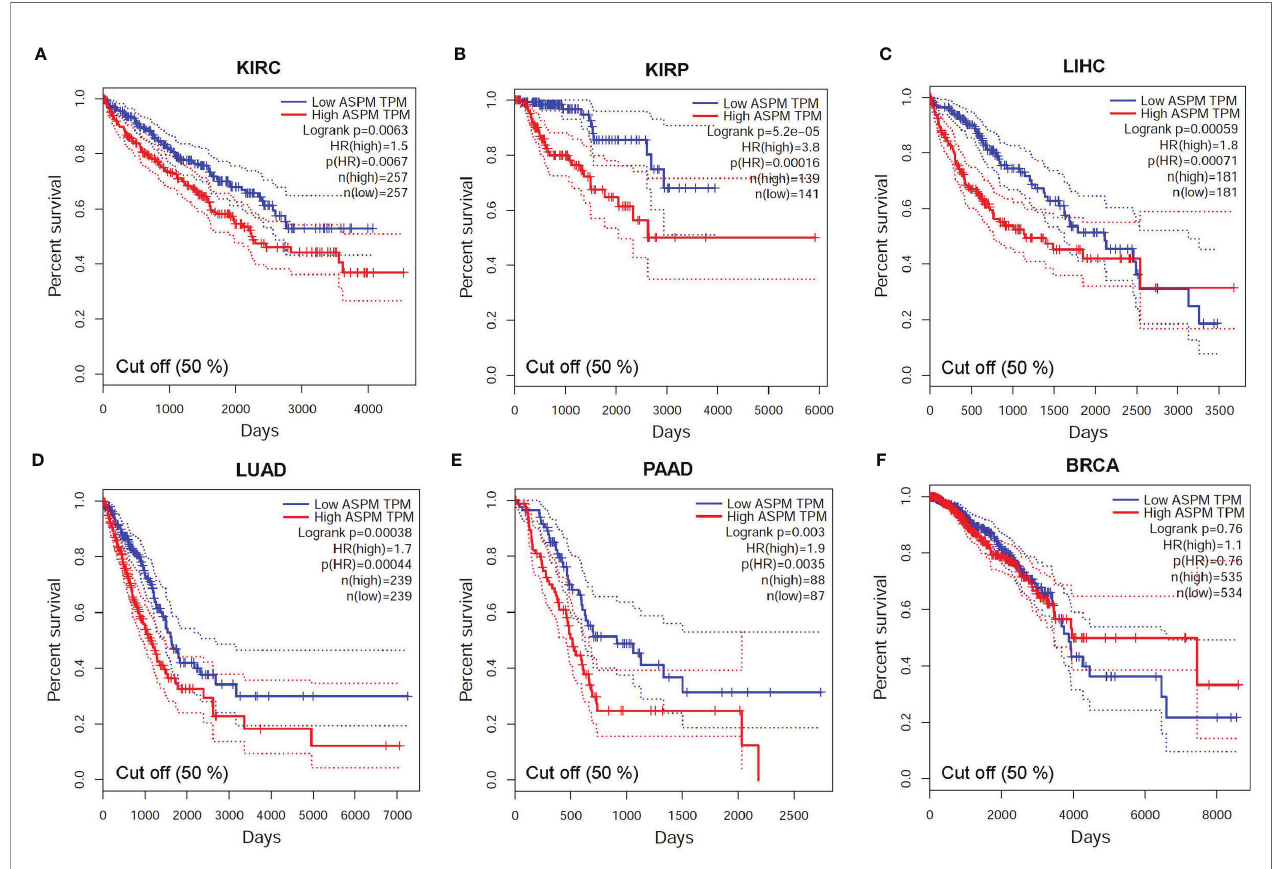
FIGURE 5 | The relationship between the transcription level of ASPM and cancer prognosis. Survival curves showing association of ASPM expression with prognosis: overall survival (OS). For the accurate interpretation of ASPM expression detection results, we set the cut-off value as 50%. (A) KIRC (HR = 1.9, p = 0.00044), (B) KIRP (HR = 3.8, p = 0.00016) (C) LIHC (HR = 1.8, p = 0.00071), (D) LUAD (HR = 1.7, p = 0.00044), (E) PAAD (HR = 1.9, p = 0.00035), and (F) BRCA (HR = 1.1, p = 0.76). HR: Hazard